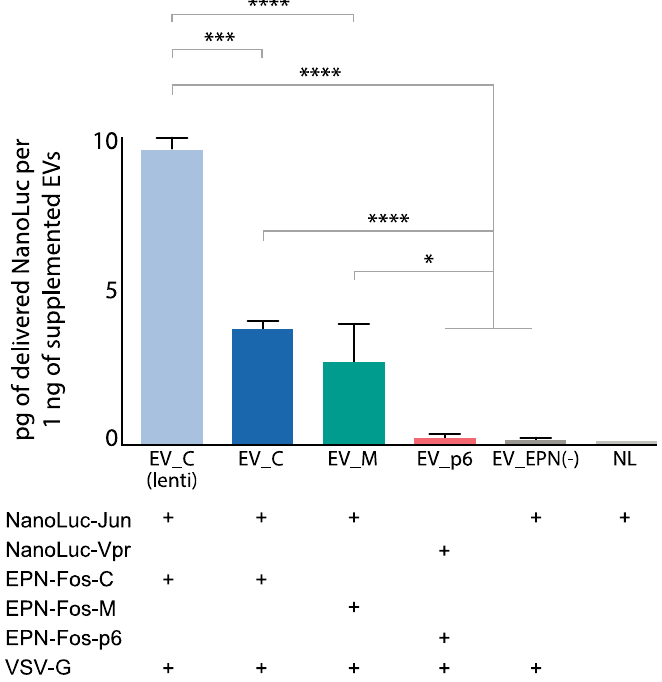
Figure 7. The level of delivered NanoLuc in cells after 2 h of incubation. Highly purified EVs